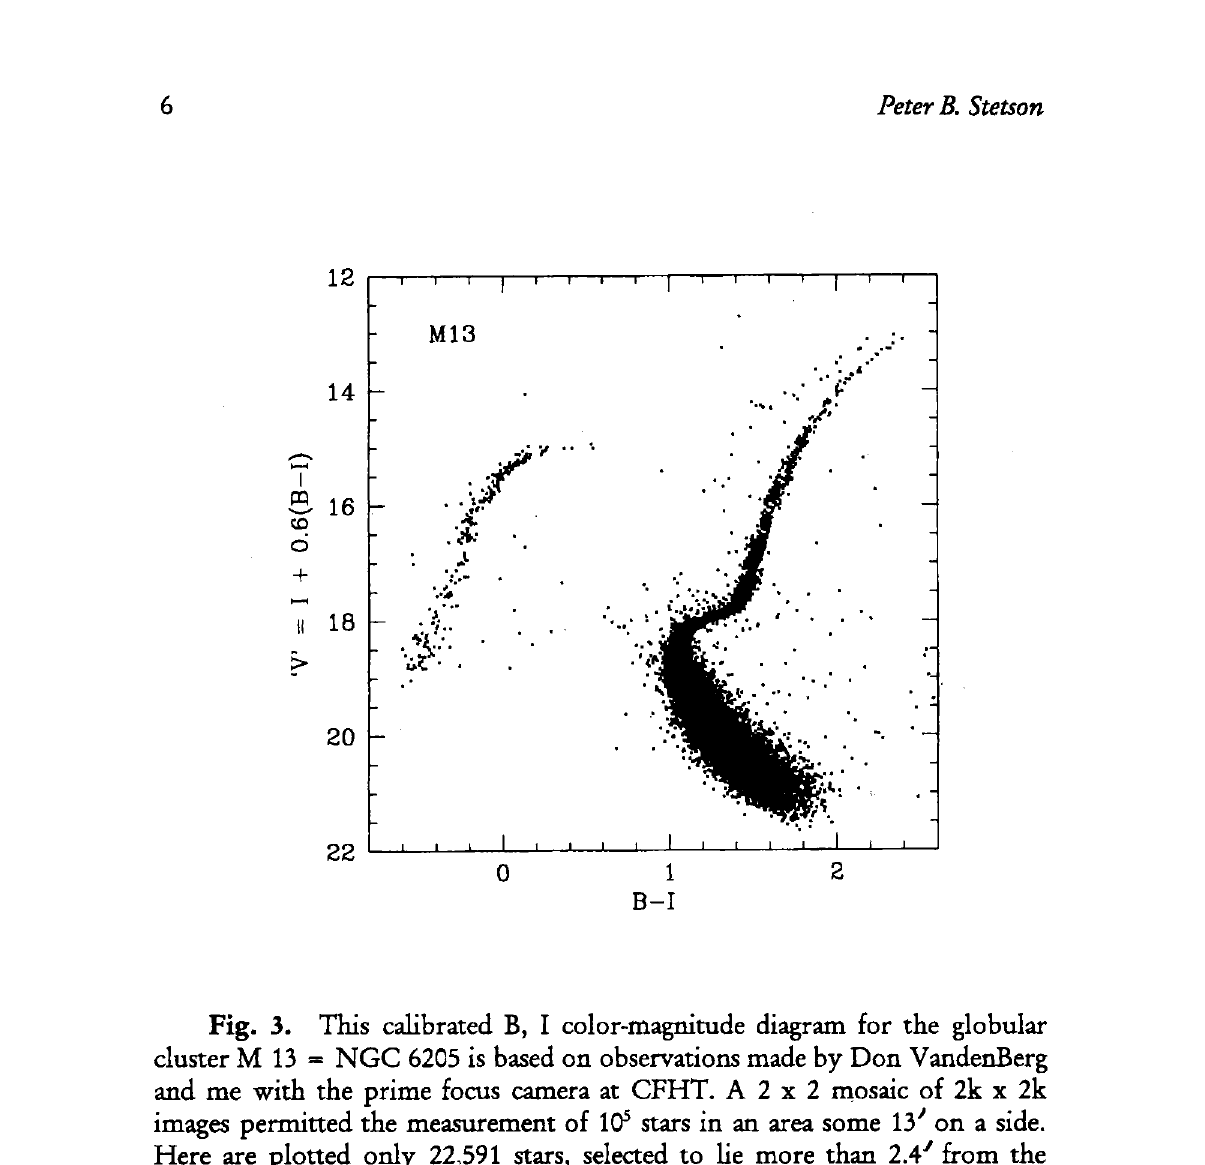
Fig. 3. This calibrated Β, I color-magnitude diagram for the globular cluster Μ 13 = NGC 6205 is based on observations made by Don VandenBerg and me with the prime focus camera at CFHT. A 2 χ 2 mosaic of 2k χ 2k images permitted the measurement of 10 5 stars in an area some 13 y on a side. Here are plotted only 22,591 stars, selected to lie more than 2.4 y from the cluster center, and to have σ(Β-Ι) < 0.05 mag. The observed thickness of the giant branch suggests a reddening gradient across the field of order ΔΕ(Β-I) = 0.004 mag/arcmin =» ΔΕ(Β - V) ~ 0.002 mag/arcmin. The asymptotic giant branch seems unexpectedly sparse. The brightest giant branch tip stars are not plotted because they are saturated in the CCD